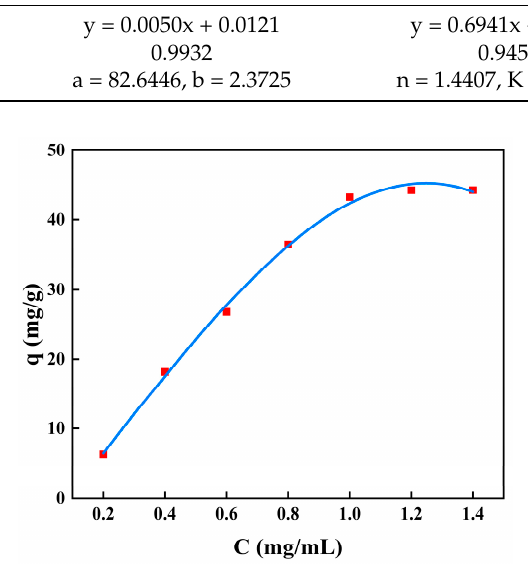
Molecules 2023 , 28 , x FOR PEER REVIEW Figure 7. The model plot of nonlinear-fitted isotherm adsorption. Figure 7. The model plot of nonlinear-fitted isotherm adsorption.